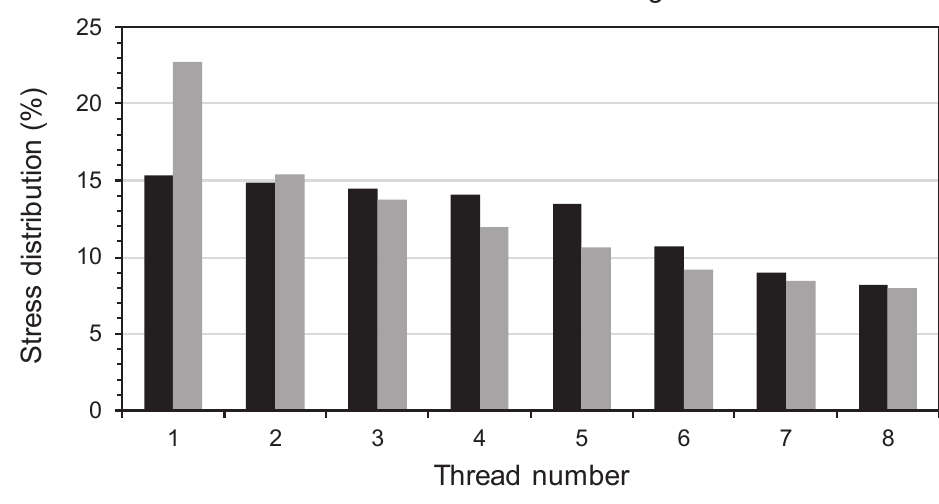
Figure 11. Percentage of stress distribution in the bolt threads .